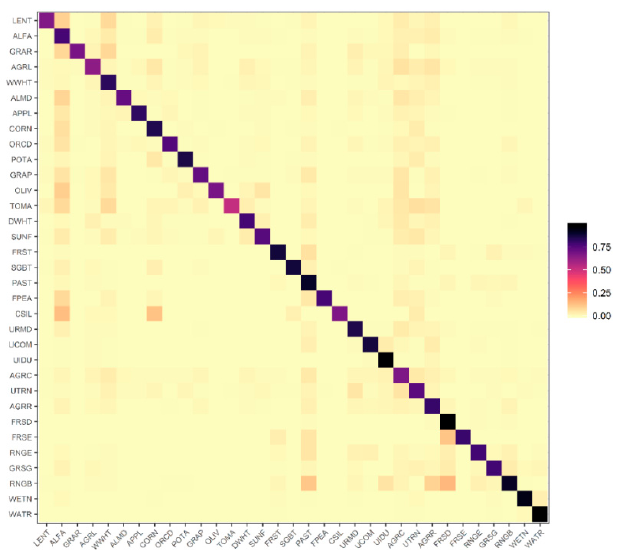
Figure 5. Heat maps representing the confusion matrix of the proposed classification algorithm.